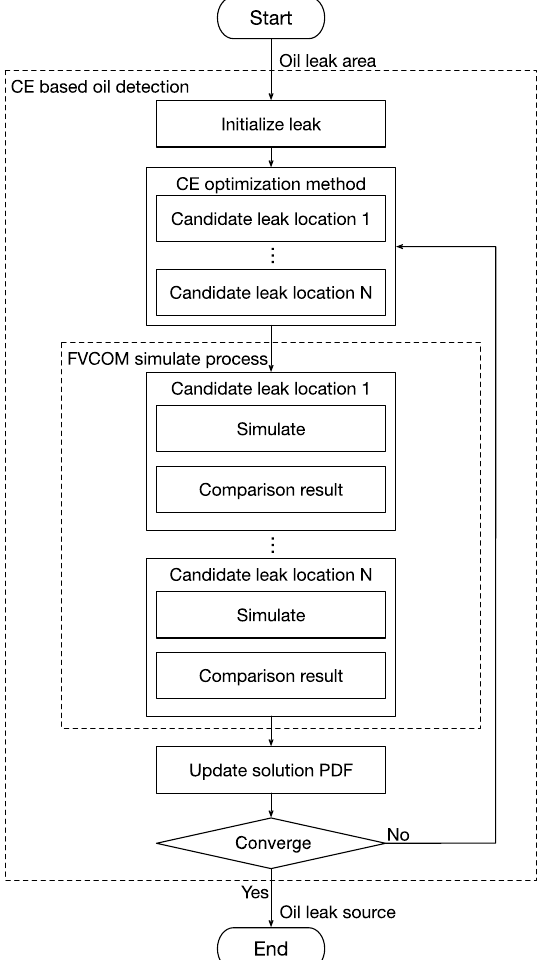
Figure 3. Illustration of the COSSD method